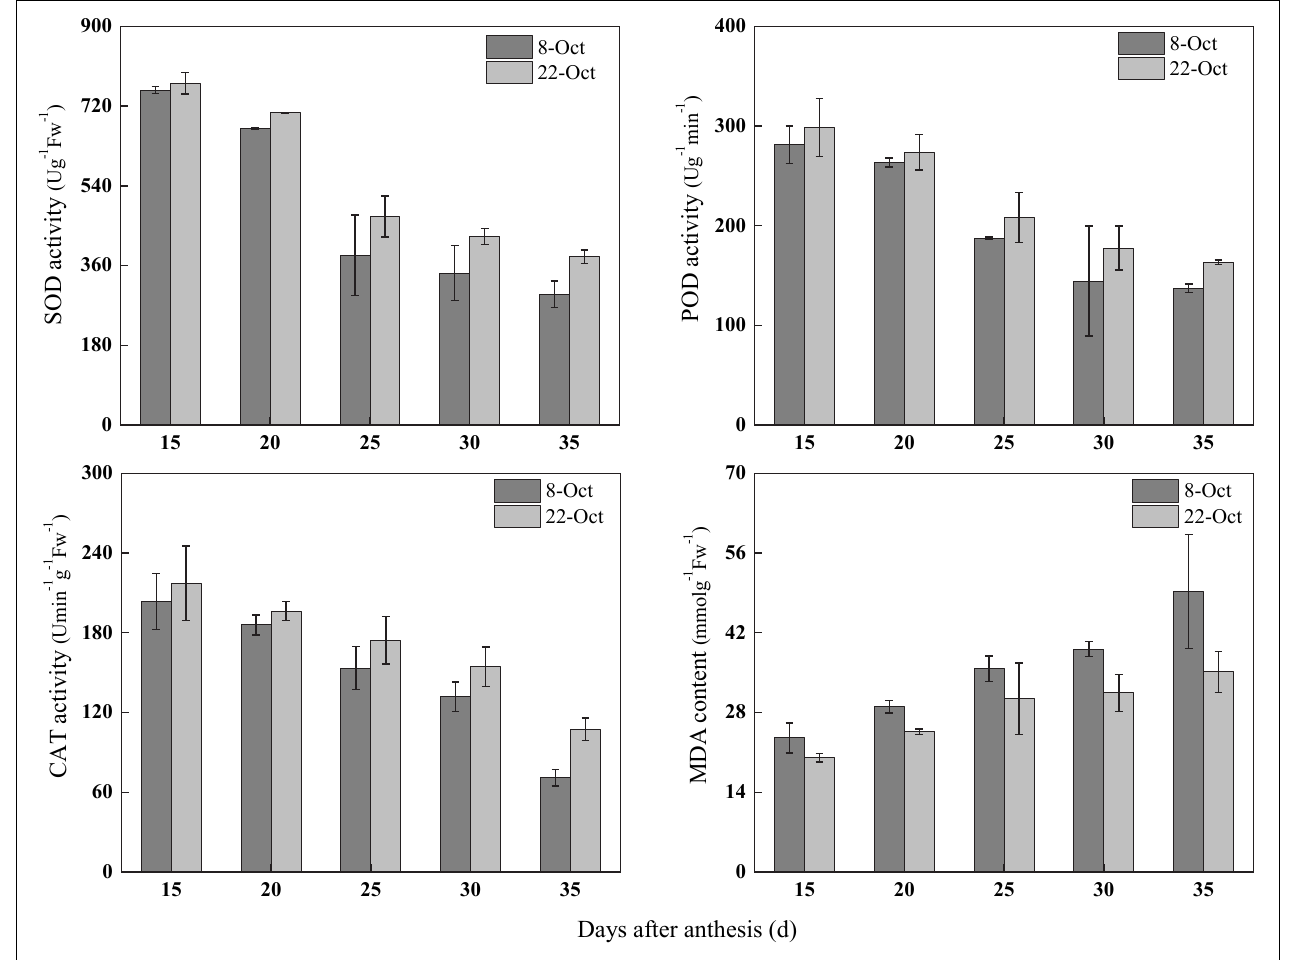
FIGURE 4 | Effect of delayed sowing on antioxidant enzymes activity and MDA content of wheat flag leaves under heat stress at late grain-filling stage.